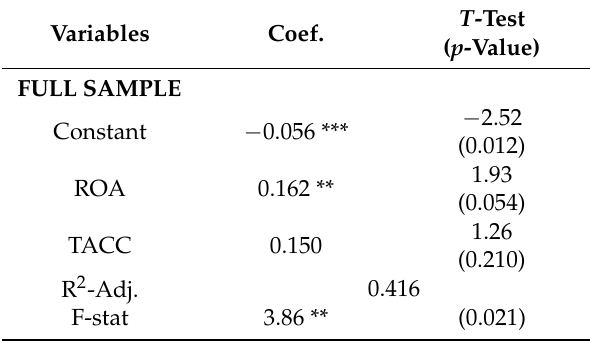
Table 5. Results on the persistence of accruals and cash